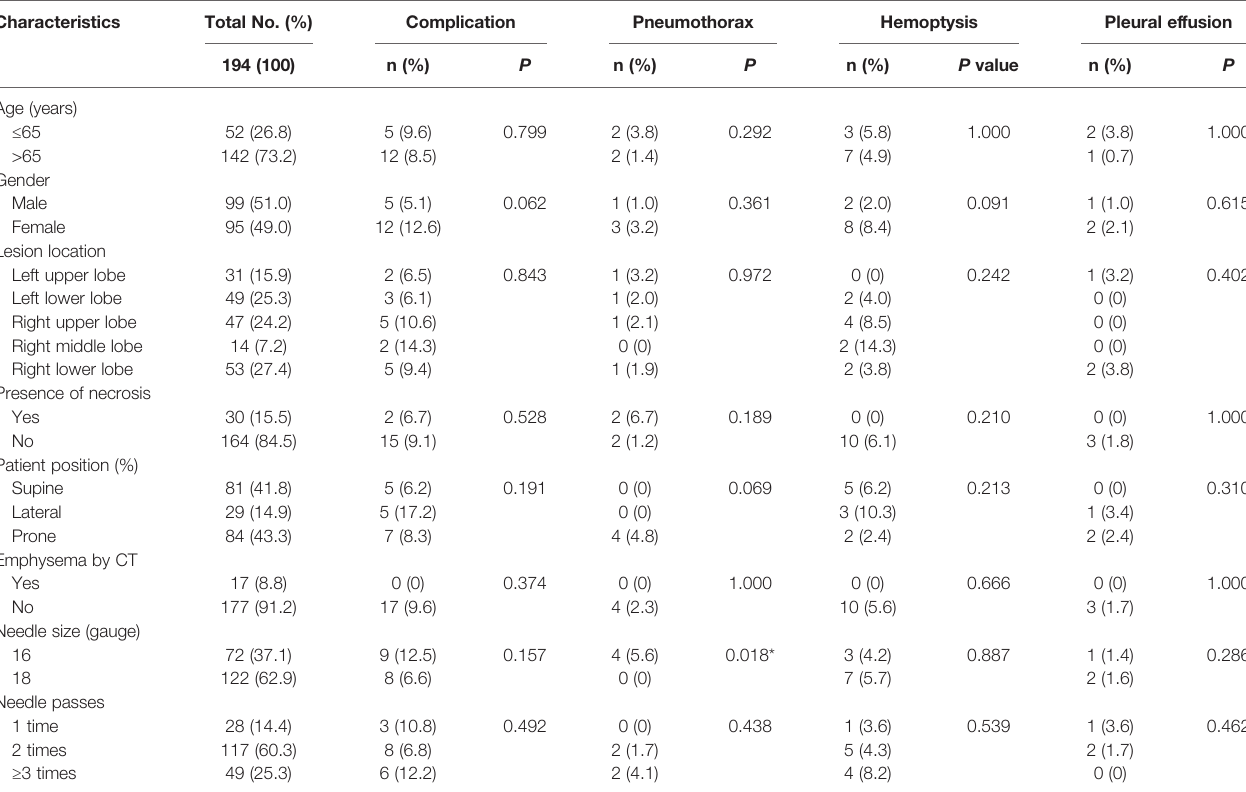
TABLE 5 | Univariate analysis of in fl uence factors for safety of ultrasound-guided percutaneous core needle biopsy for peripheral pulmonary lesions ≤ 2 cm.